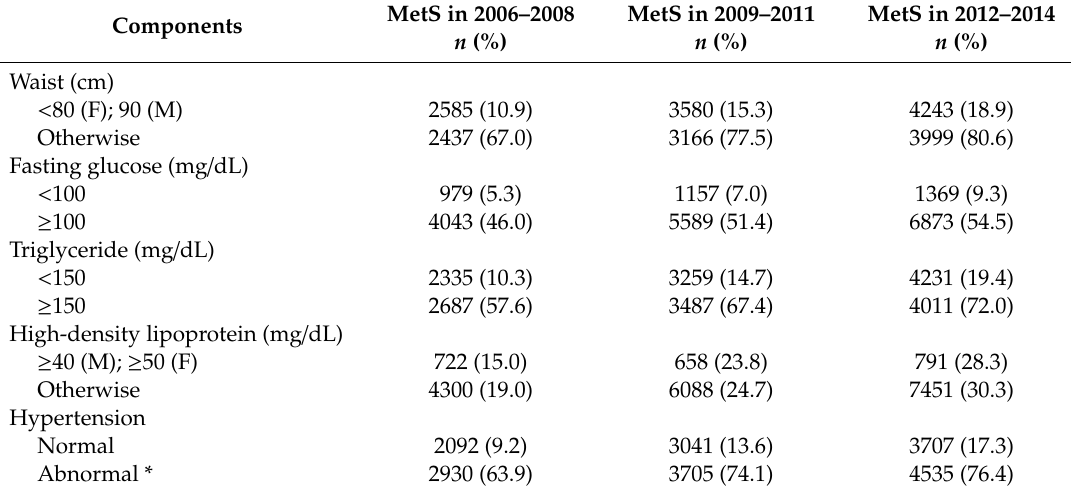
Table 2. Components of metabolic syndrome (MetS) over the three study